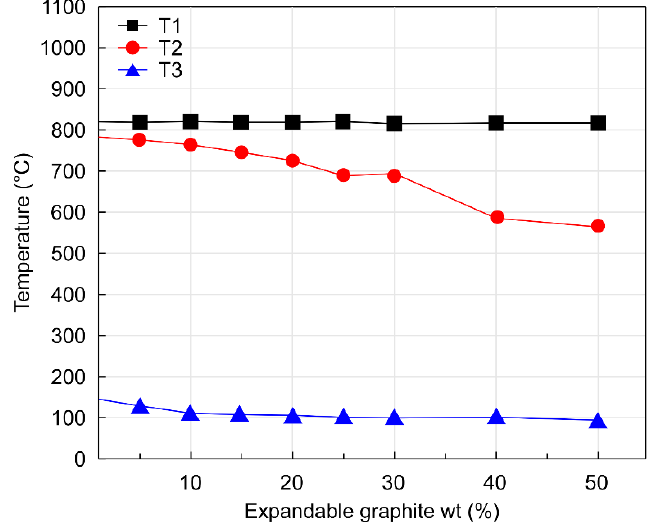
Materials 2020 , 13 , x FOR PEER REVIEW Figure 12. ( a ) Schematic of heat flow in cone calorimetry experiment and ( b ) image of expanded layer.